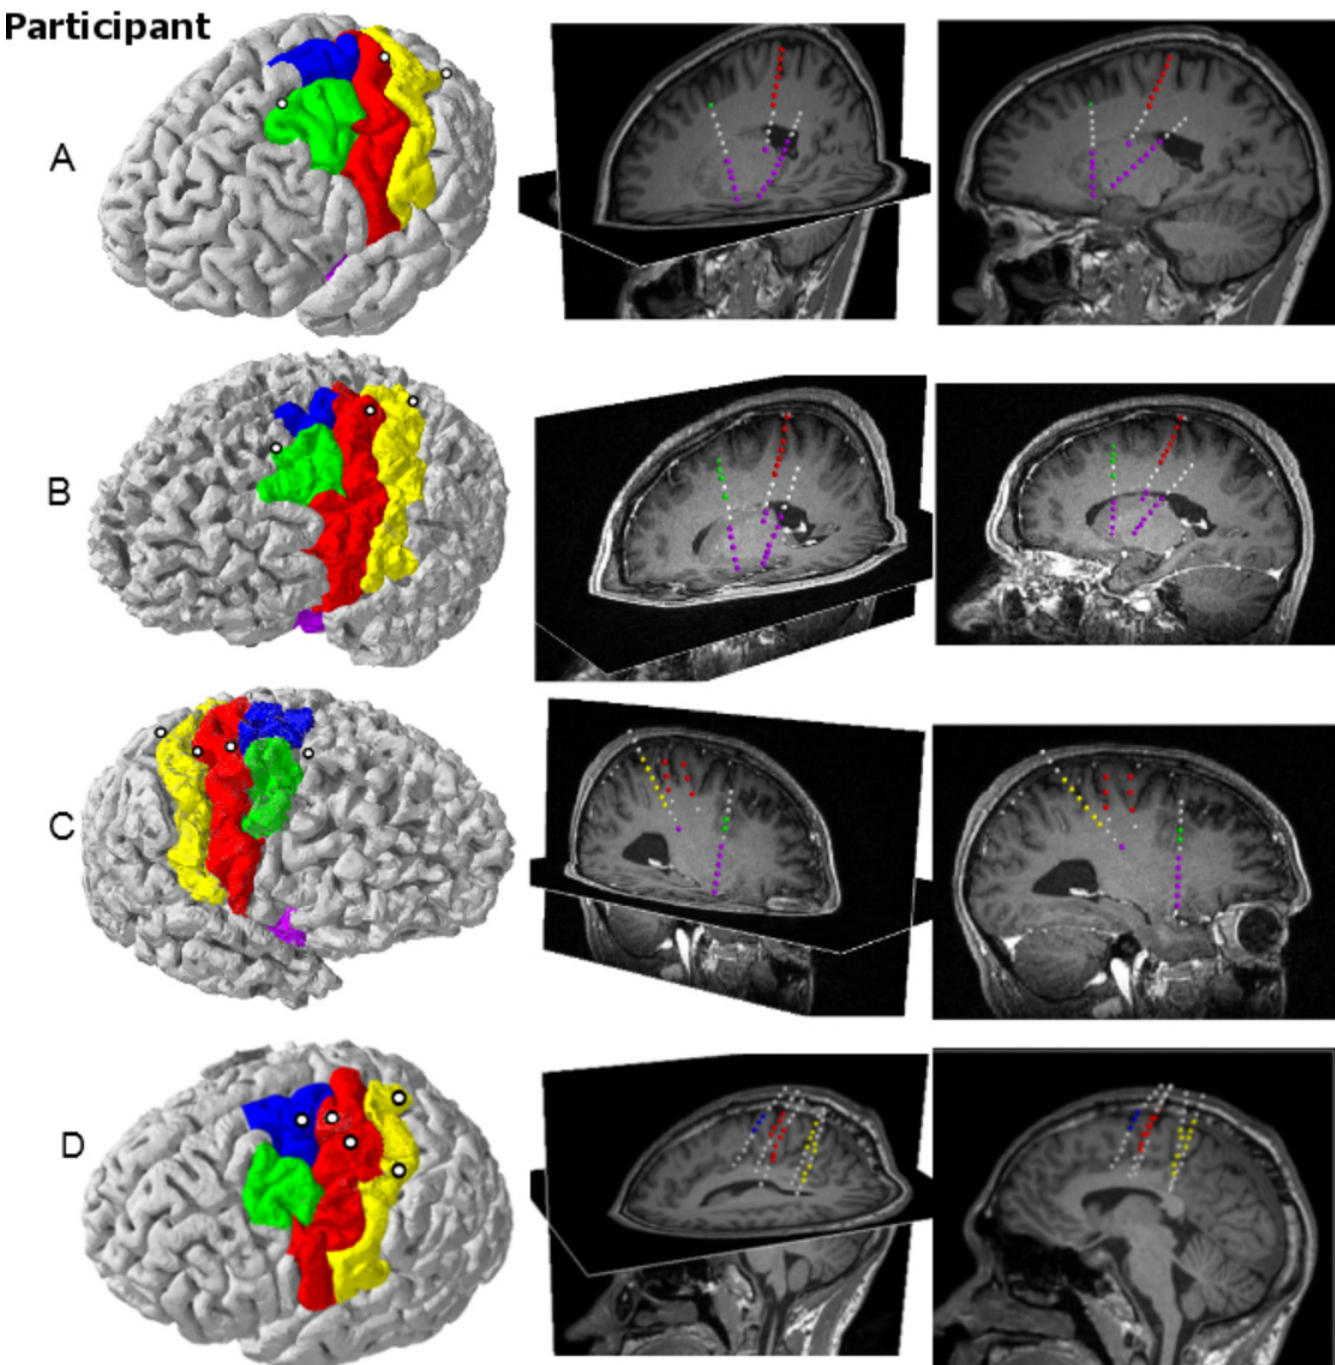
Fig 2. Locations of electrodes. Each row corresponds to an individual participant (A-D). Left : Participant specific cortical surface reconstructions (red: motor cortex, yellow: primary sensory cortex, green: premotor cortex, blue: supplementary motor cortex, purple: insular cortex) and electrode penetration sites (white circles). Middle : Oblique views of sagittal and axial MRI slices showing the electrode trajectories. Electrode contacts are color-coded according to the cortical region they pass by or through. The MRI slices shown are located as close to the electrodes as possible without obscuring any of the contacts. Right : Sagittal views showing the actual depths of the